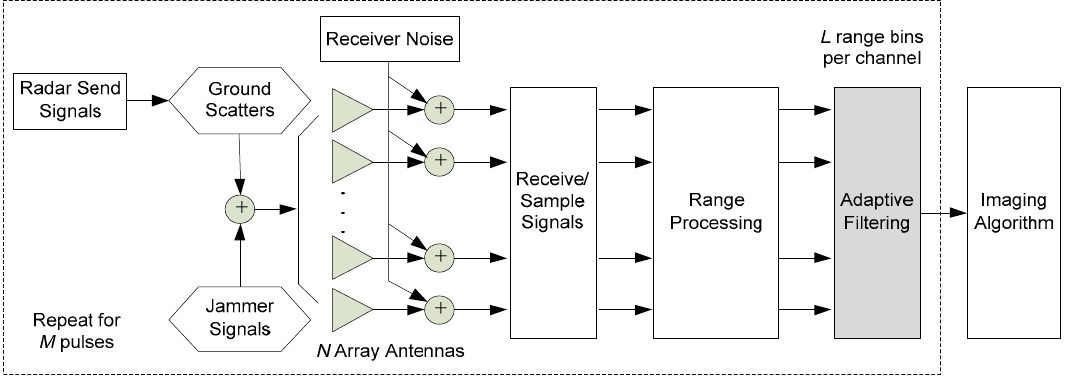
Figure 2. Processing diagram of the multi-channel SAR.